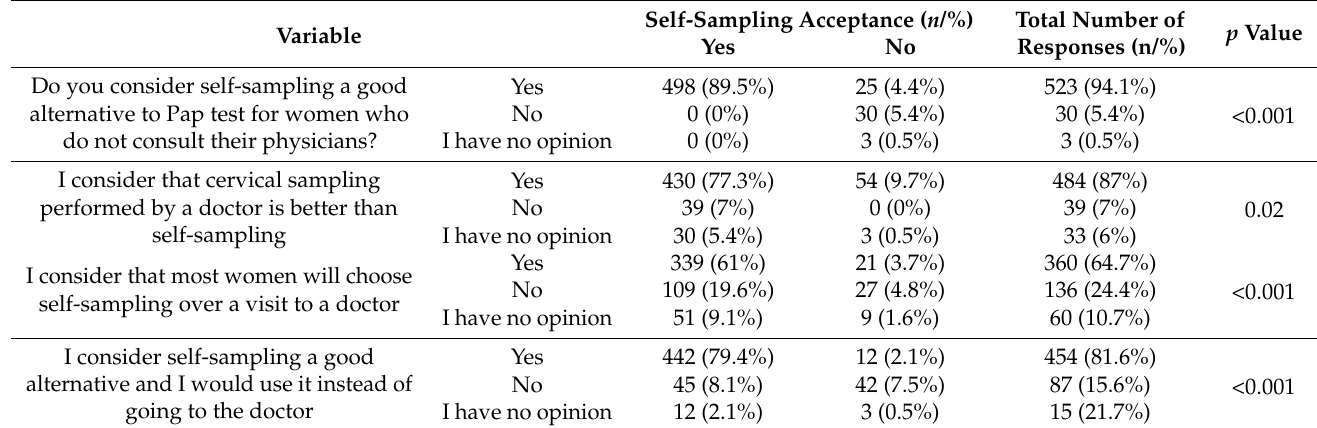
Table 2. The acceptability of vaginal HPV self-sampling among the respondents, considering their opinions regarding cervical cancer